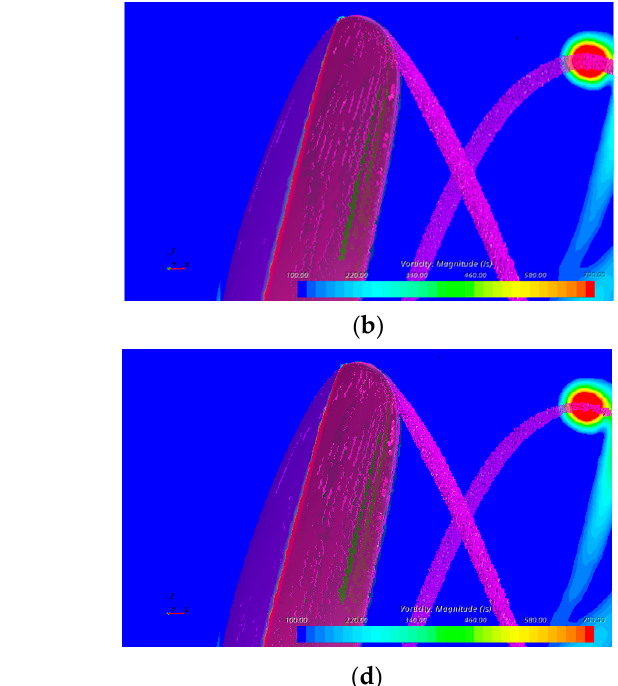
Figure 13. Development of TVC ( a : rigid, b : model 1, c : model 5, σ = 1.2). The contours of the vorticity magnitude and iso-surface of the Q-Criteria ( Q = 1/2 || ω || 2 − ||D’|| 2 ) for composite propellers (models 1 and 5) in the cavitating flow at the same rotation speed are shown in Figure 14, where ω and D’ are the vorticity tensor and